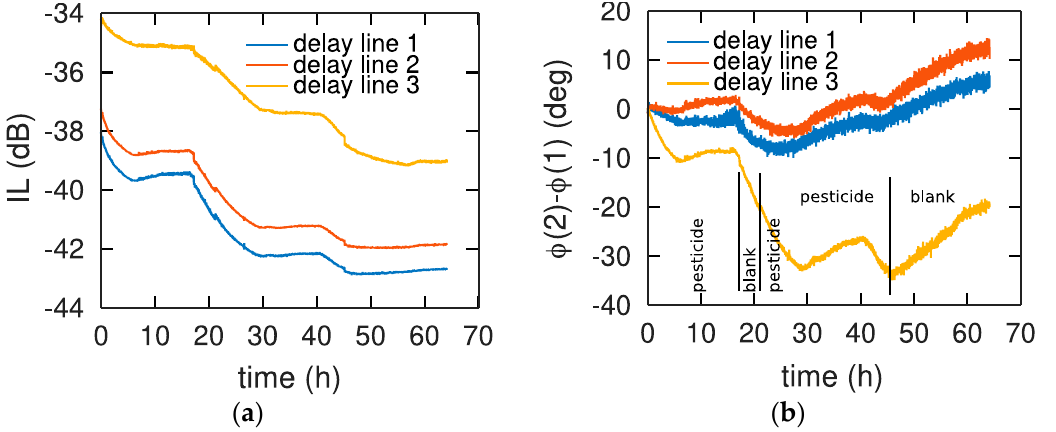
Figure 3. Evolution of ( a ) the insertion loss (IL) of echo 1 and ( b ) the phase difference between echo 1 and echo 2 separated by 800 ns. The measurement steps are indicated on the bottom for each chart since all steps were timestamped, with water-acetonitrile mixture (named blank) or water-acetoni- trile containing chlorpyrifos solution (named pesticide) with PBMA as sensing layer.